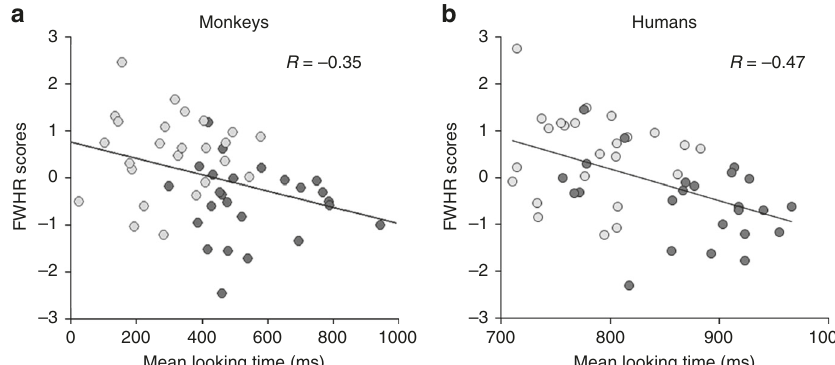
Fig. 4 Monkeys and humans ‘ correlation between mean looking time and FWHR. Mean looking time in milliseconds (ms) of ( a ) monkeys ( r (48) = − 0.35, p < 0.05, Pearson correlation) and ( b ) humans ( r (48) = − 0.47, p < 0.001) are negatively correlated to the facial width height ratio (FWHR) scores, i.e., longer and narrower faces were looked longer by both species. Light grey points correspond to trustworthy faces and dark grey points to